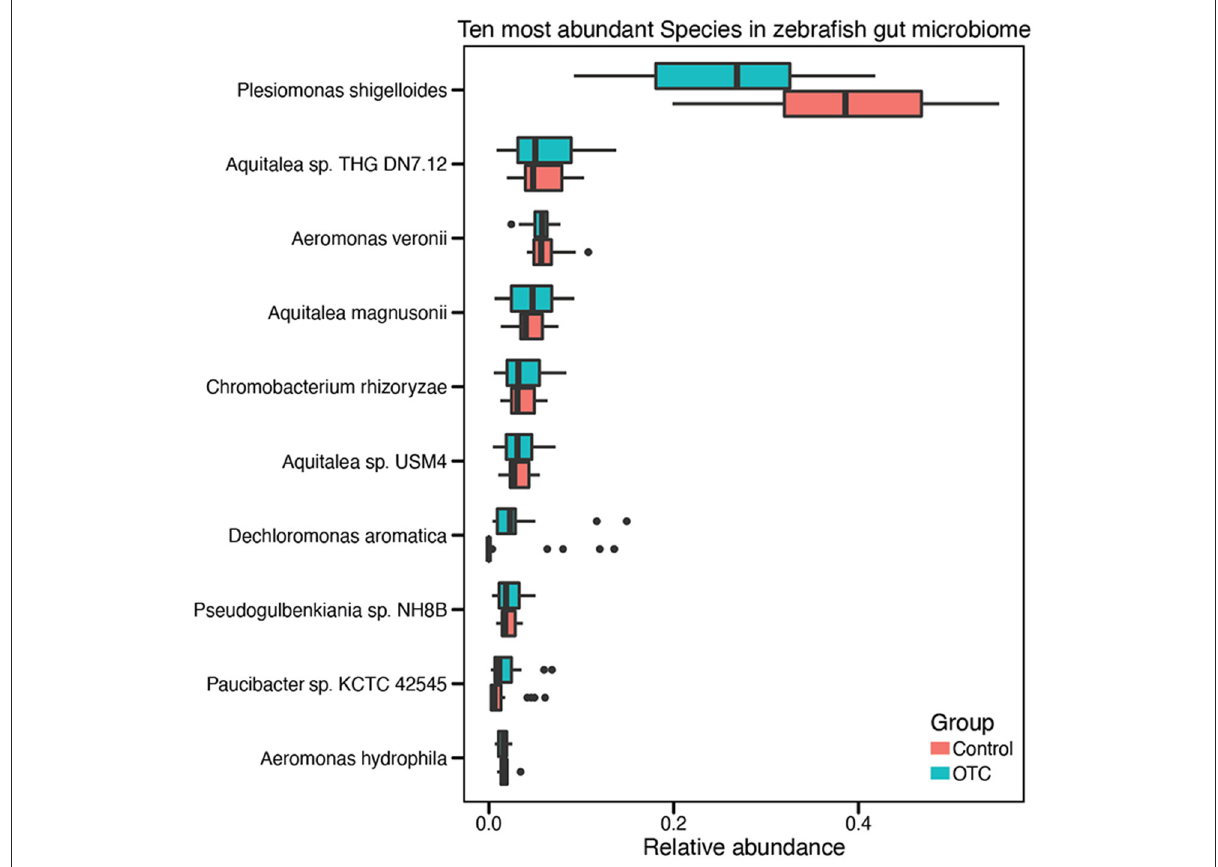
FIGURE3 Distribution of the ten highly abundant microbial species in the zebrafish gut microbiome. Taxonomic analysis of the sequencing reads identified more than 300 microbial species in the zebrafish gut microbiome. However, for visual convenience, here we shown only the top ten microbial species. The complete list of species and their relative abundances are provided in Supplementary Table 2.